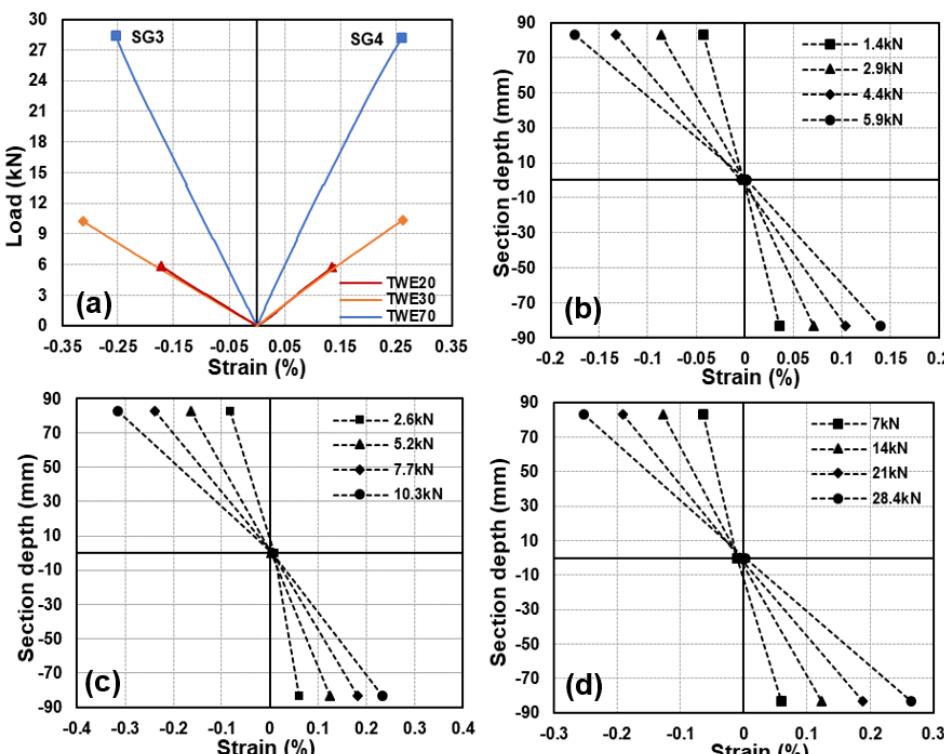
Figure 8. Strain responses at midspan (section D). ( a ) Load – strain responses for TWE specimens in comparison to TW specimens without environmental exposure from [45,46]; ( b ) strain distribution along depth for TWE20; ( c ) strain distribution along depth for TWE30; and ( d ) strain distribution along depth for TWE70.